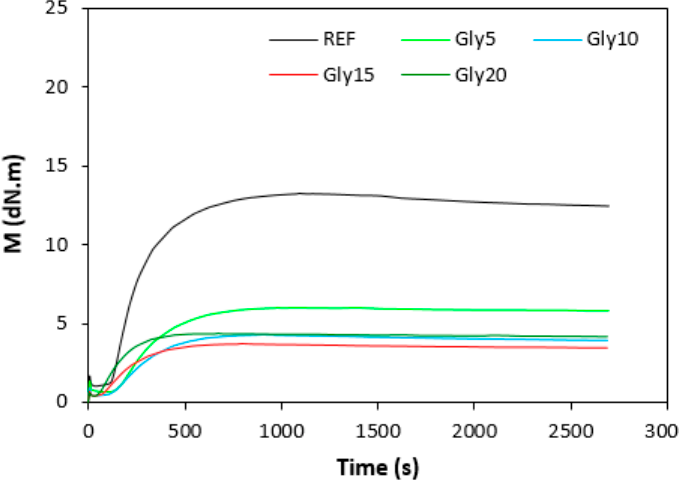
Figure 1. Vulcanization isotherms for rubber compounds based on SBR.